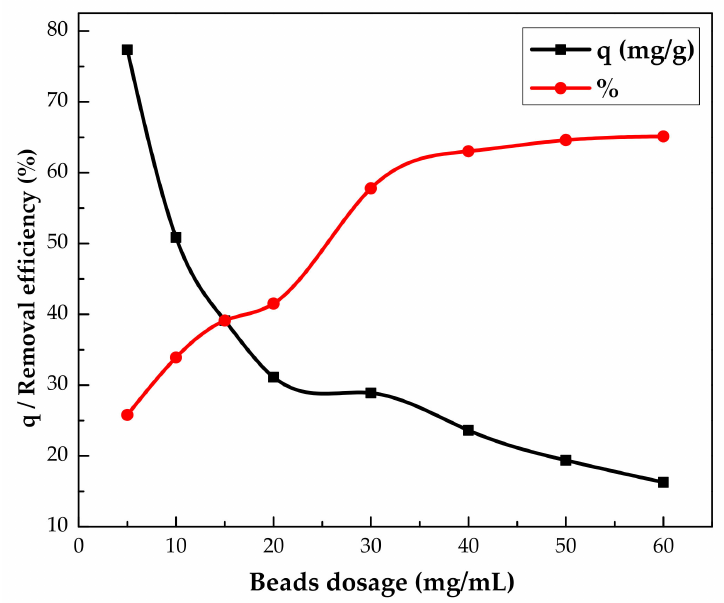
Figure 8. Effect of IL–agar–alginate beads dosage on the adsorption capacity and on the removal efficiency of phenol ( Ci = 150 mg/L, pH of 2, 150 rpm, 2 h and at 25 ◦